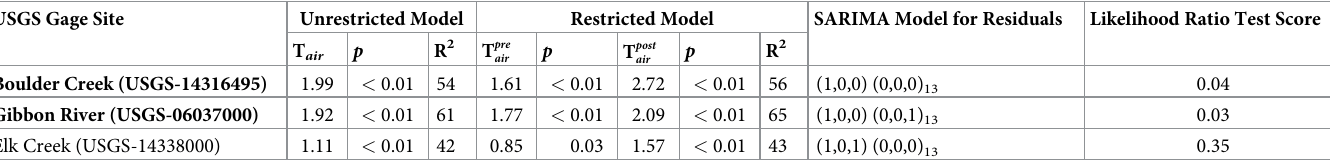
Table 4. Coefficients and fitness of restricted and unrestricted regression models for pre- and post-fire weekly winter air temperature—accumulated degree-days relations for studied stream sites. Sites in bold are those where the restricted regression model was significantly ( p < 0.05) different from the unrestricted regression